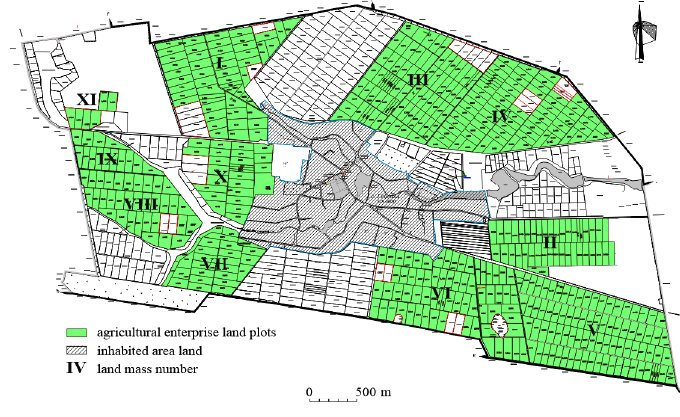
Figure 1. Agricultural enterprise land tenure